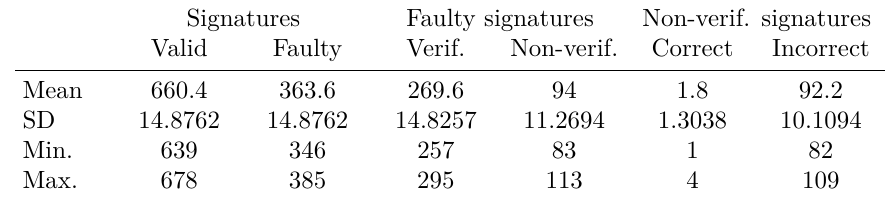
Table 14: Analysis of the collected signatures in N = 5 fault attacks against SPHINCS + - shake-256s-robust at layer l ∗ =